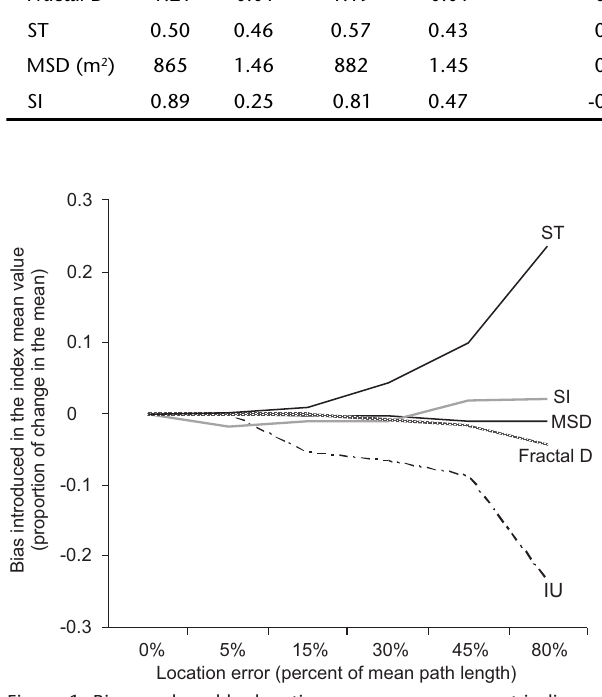
Figure 1. Bias produced by location errors on movement indices. Location errors were defined as a percentage of mean path length, and index mean values (not shown) were based on 150 individual paths of the marsupial D. aurita . (IU) Intensity of Use, (ST) Straightness index, (MSD) Mean Square Displacement, (SI) Sinu- osity